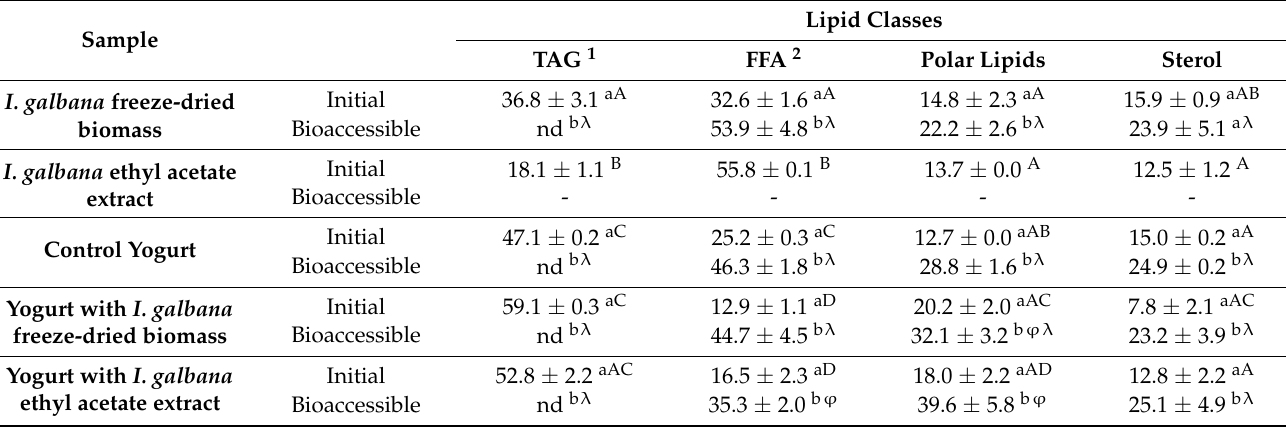
Table 2. Lipid class distribution (% of total lipid) before and after digestion (bioaccessible fraction) of I. galbana freeze-dried biomass, I. galbana ethyl acetate extract, control yogurt, yogurt with 2% ( w / w ) of I. galbana freeze-dried biomass and yogurt with 2% ( w / w ) of I. galbana ethyl acetate